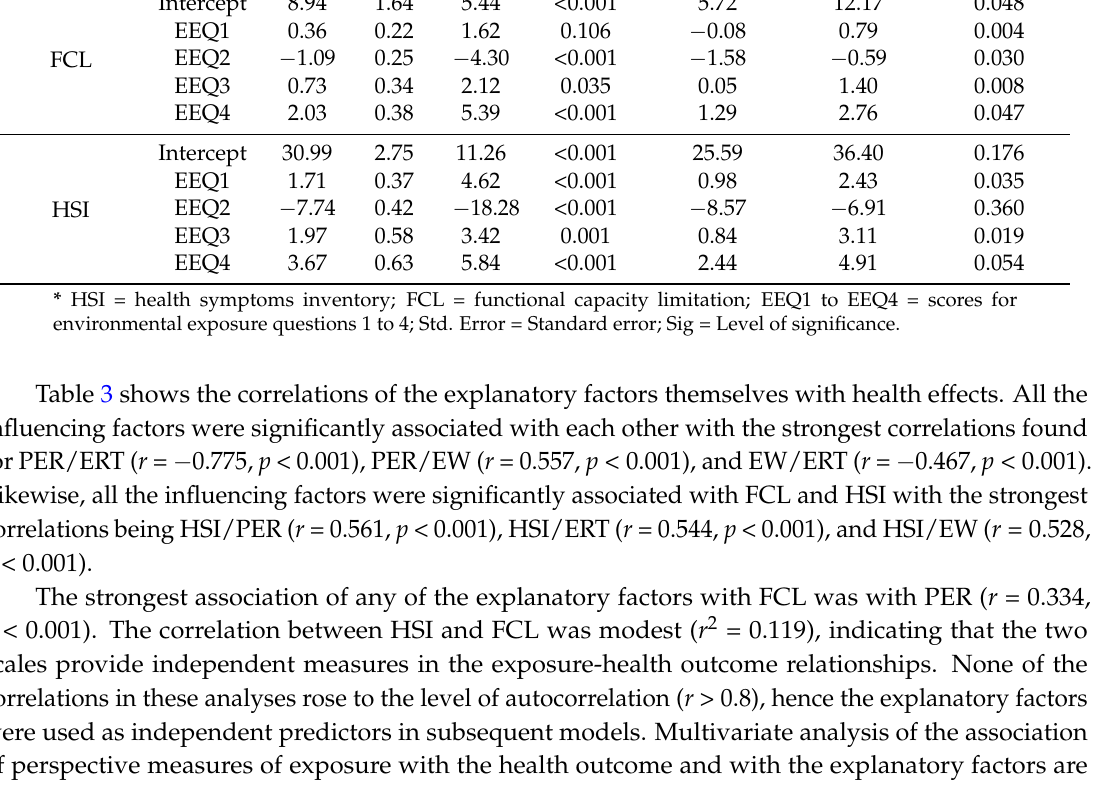
Table 4. Relationships between scores for subjective exposure to oil pollution and health outcomes. Std. Dependent Variable * B